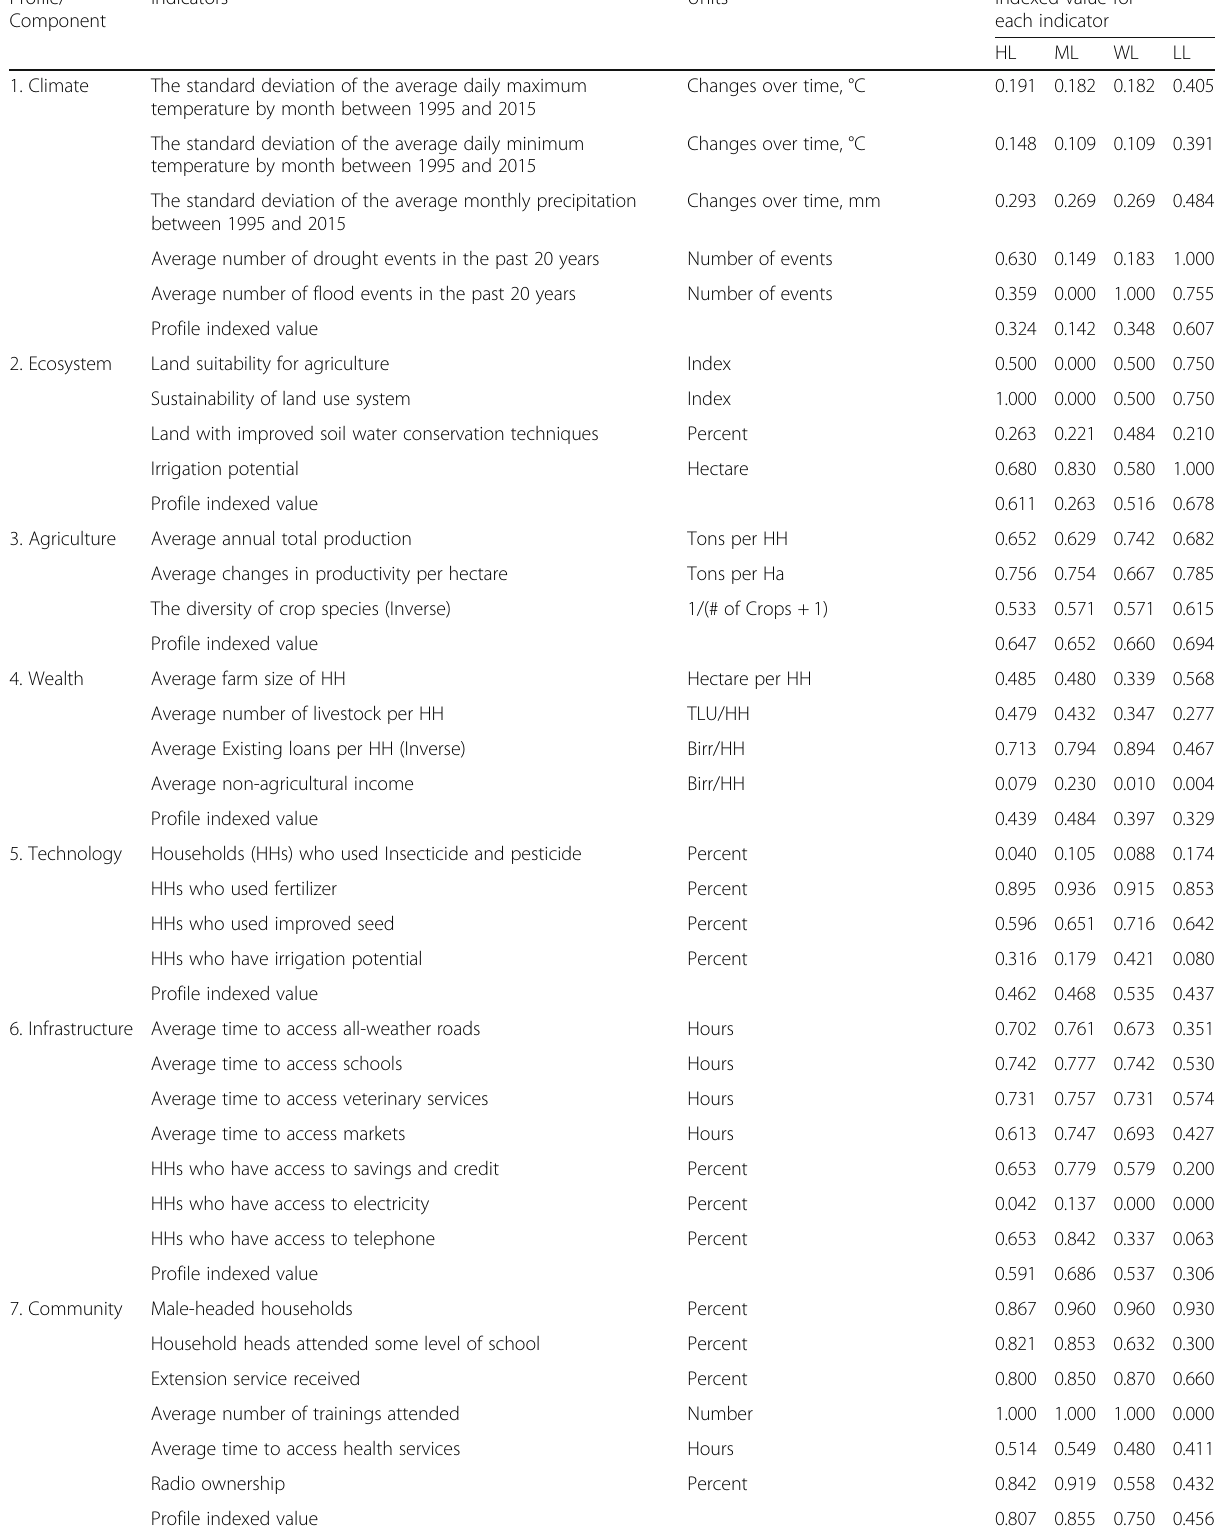
Table 2 Indexed indicators, profiles, and overall LVI for highland, midland, wetland, and lowland AESs Profile/